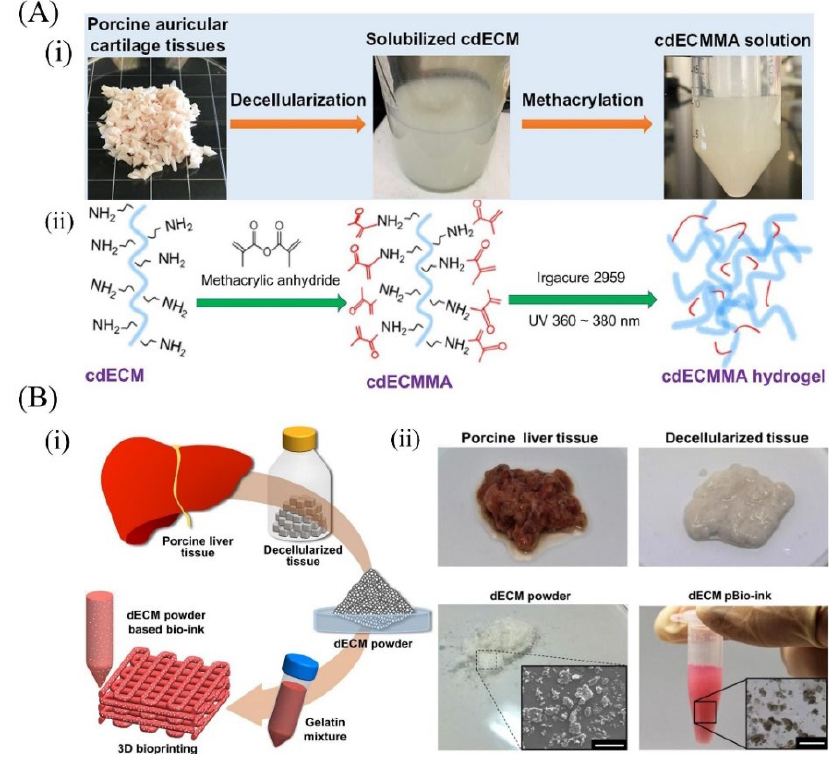
Figure 3. Strategies for preparing decellularized bioinks. ( A ) Illustration of cdECMMA bioink for- mulation containing cells and three-dimensional (3D) bioprinting process using